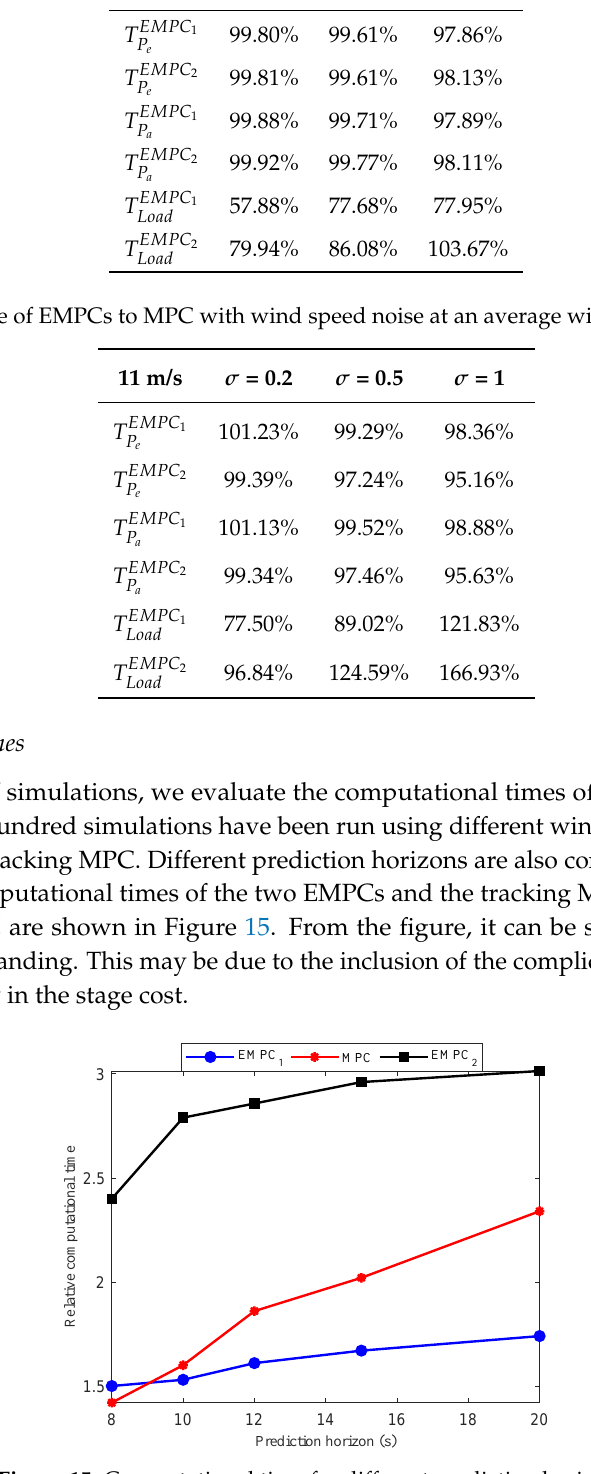
8 m/s σ = 0.2 σ = 0.5 σ = 1 T EMPC 1 99.80% 99.61% 97.86% P e T EMPC 2 99.81% 99.61% 98.13% P e T EMPC 1 99.88% 99.71% P a